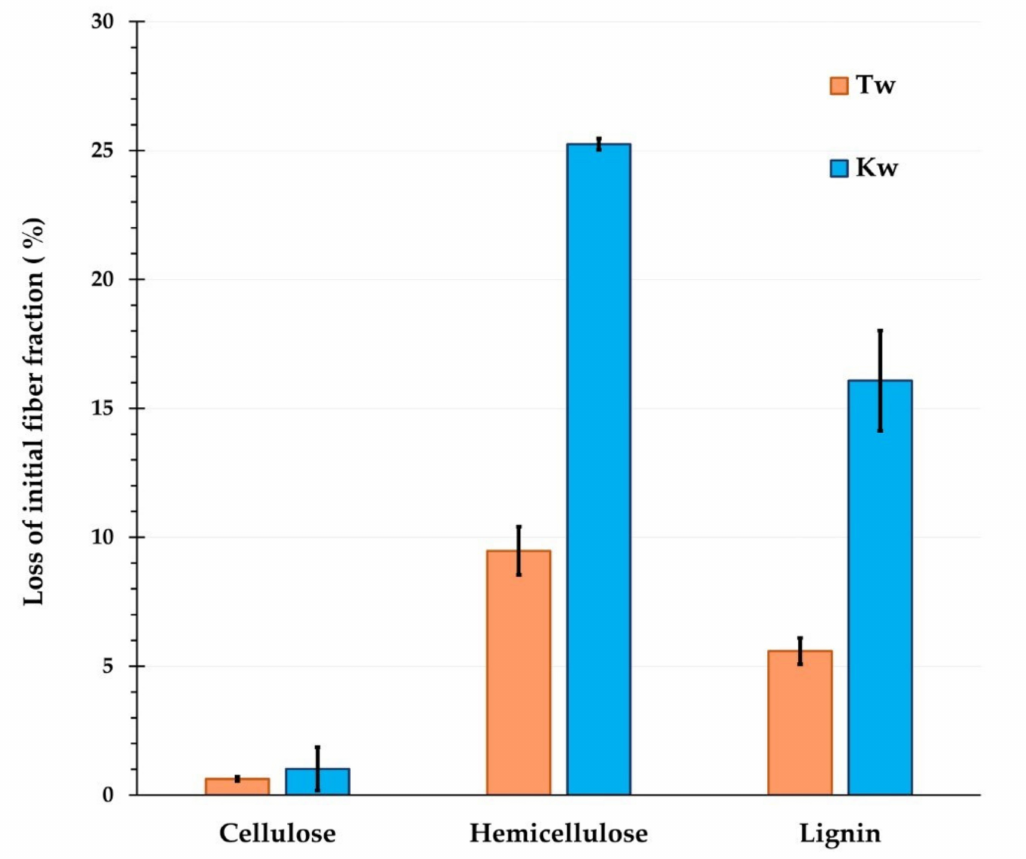
Figure 1. Loss (%) of initial fiber fractions after the washing step following the pre-treatment with KOH (Kw) or without KOH (Tw). Vertical bars represent the standard deviation of the mean ( n =